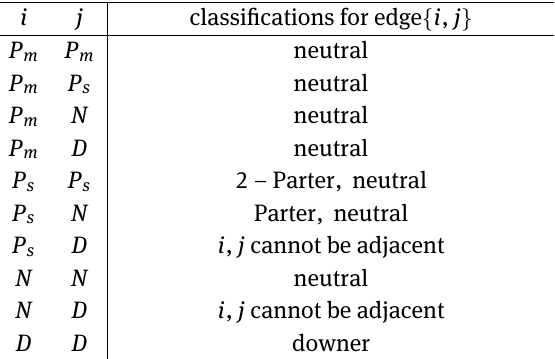
classifications for edge { i , j